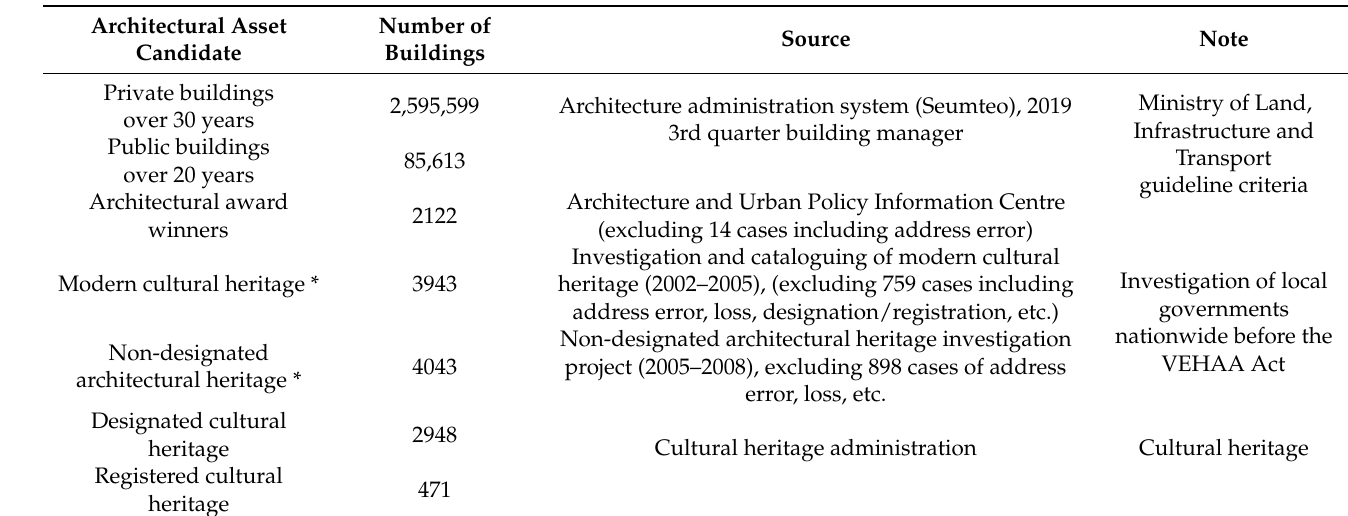
Table 1. A summary of the collected data